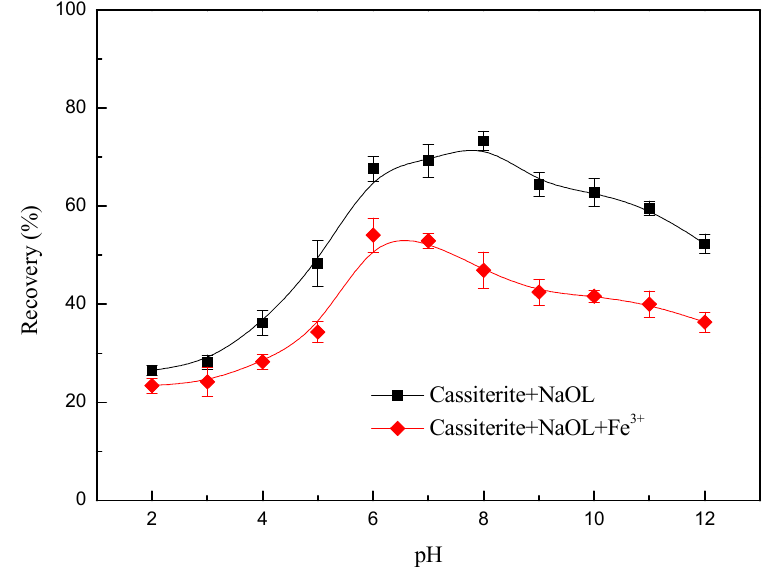
Figure 8. Flotation recovery of cassiterite as a function of pH with and without Fe 3+ (Fe 3+ : 8 × 10 − 5 mol/L; NaOL: 4 × 10 − 4 mol/L).